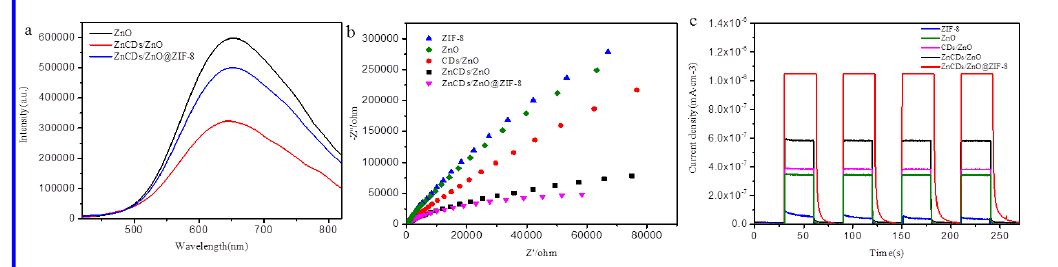
Figure 7. ( a ) Fluorescence emission. ( b ) Electrochemical impedance spectrum. ( c ) Transient photocurrent response of ZnCDs/ZnO@ZIF-8 and related materials.